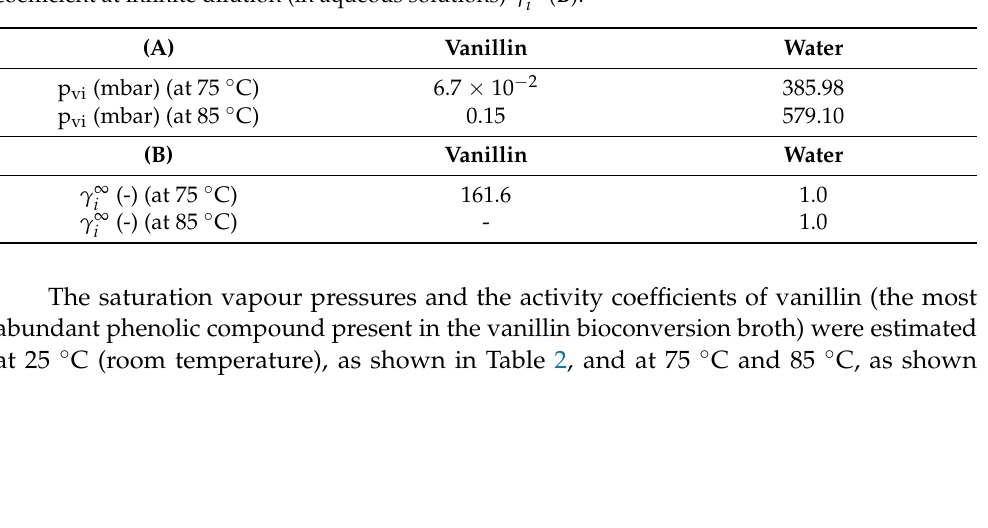
Table 4. Values of the estimated vapour pressure p vi (mbar) ( A ) and of the estimated activity coefficient at infinite dilution (in aqueous solutions) γ ∞